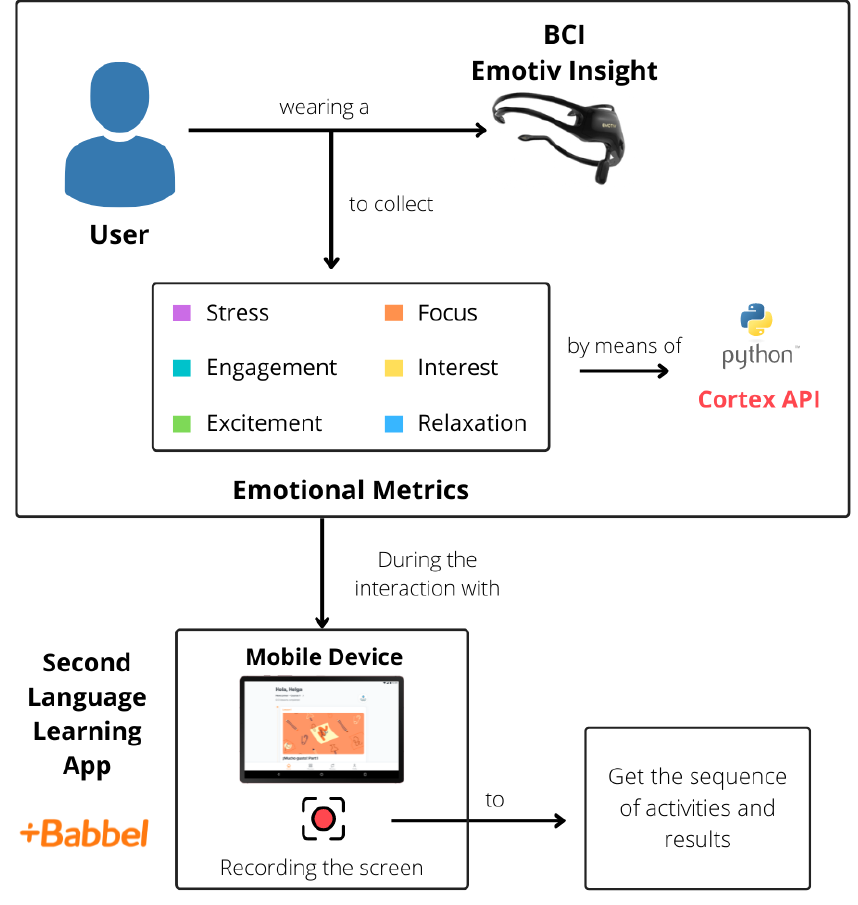
Figure 1. General approach to data collection.